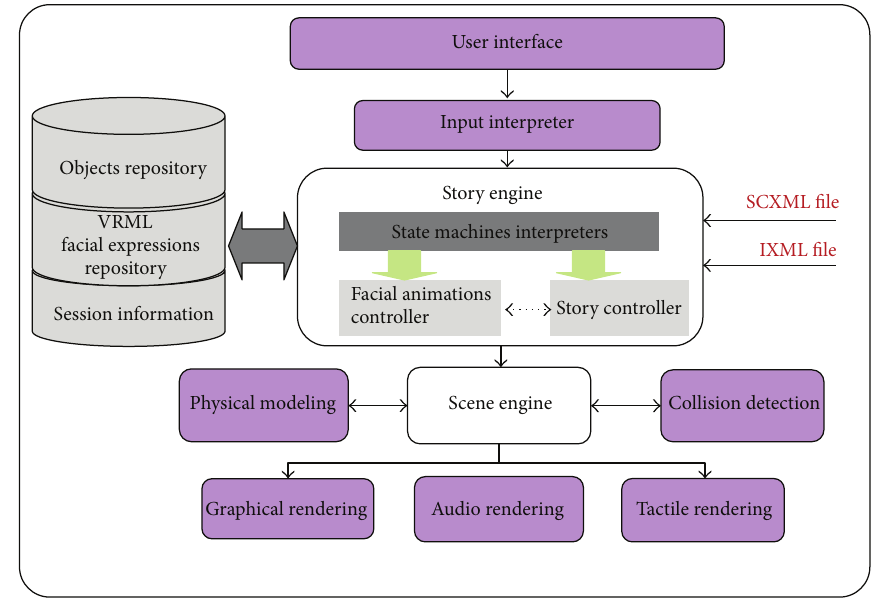
Figure 4: Proposed game engine architecture.